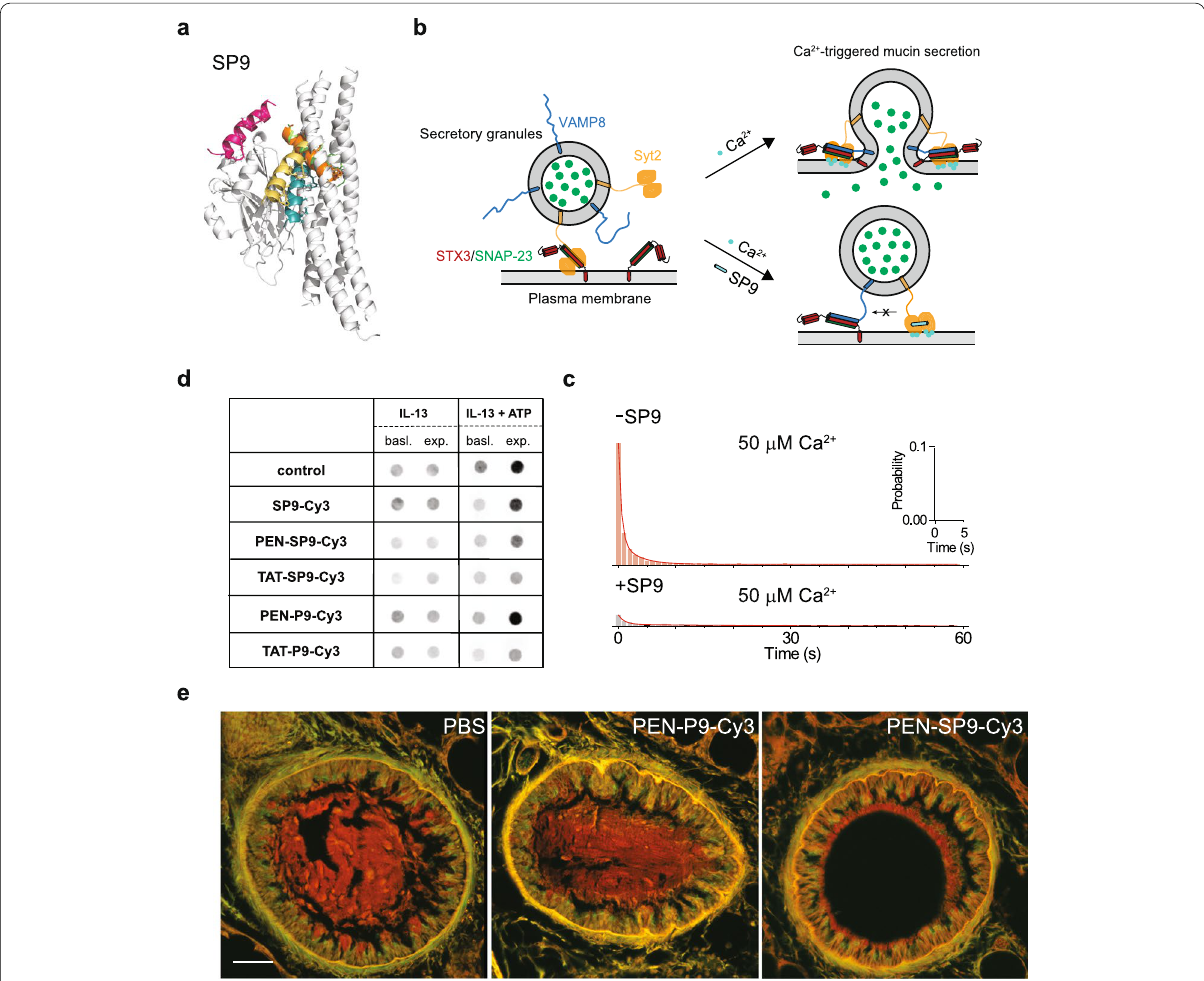
Fig. 7 Inhibition of mucus hypersecretion by a stapled peptide. a Molecular dynamics simulations of SP9-Syt1-C2B complex superimposed on the structure of the primary interface (gray). b The therapeutic strategy to inhibit mucus hypersecretion. Binding of SP9 to Syt2 blocks the interaction between Syt2 and SNARE complex, thereby disrupts the Ca 2 + -triggered mucus hypersecretion. c SP9 inhibits Ca 2 + -triggered fusion probability in a reconstituted system. d SP9 inhibits mucin secretion from airway epithelial cells. Image represents western blots for MUC5AC on apical surface of untreated HAECs, or HAECs treated with different peptides. e SP9 inhibits mucin secretion and airway occlusion in mice. Images represents transverse sections of bronchial airways of mice with asthma pre-treated with PBS or peptides. Panels a, c-e, are adapted from